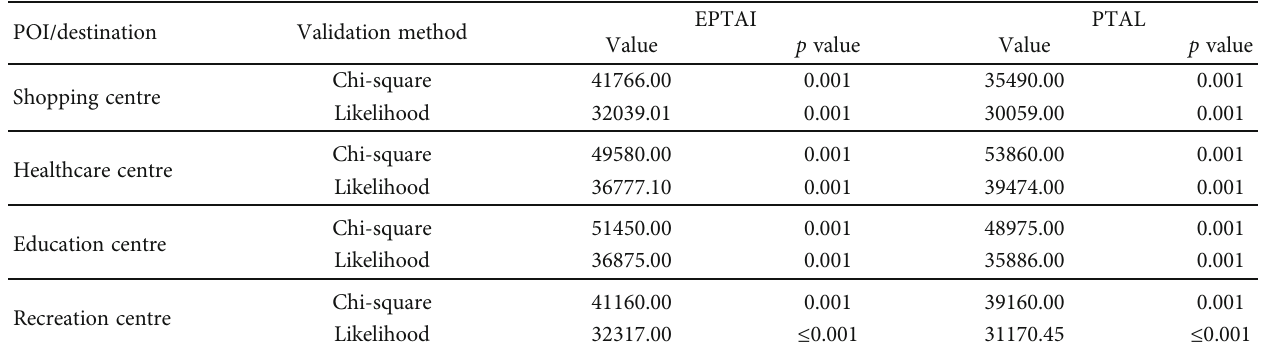
Table 7: Chi-square-based measure comparison for EPTAI and